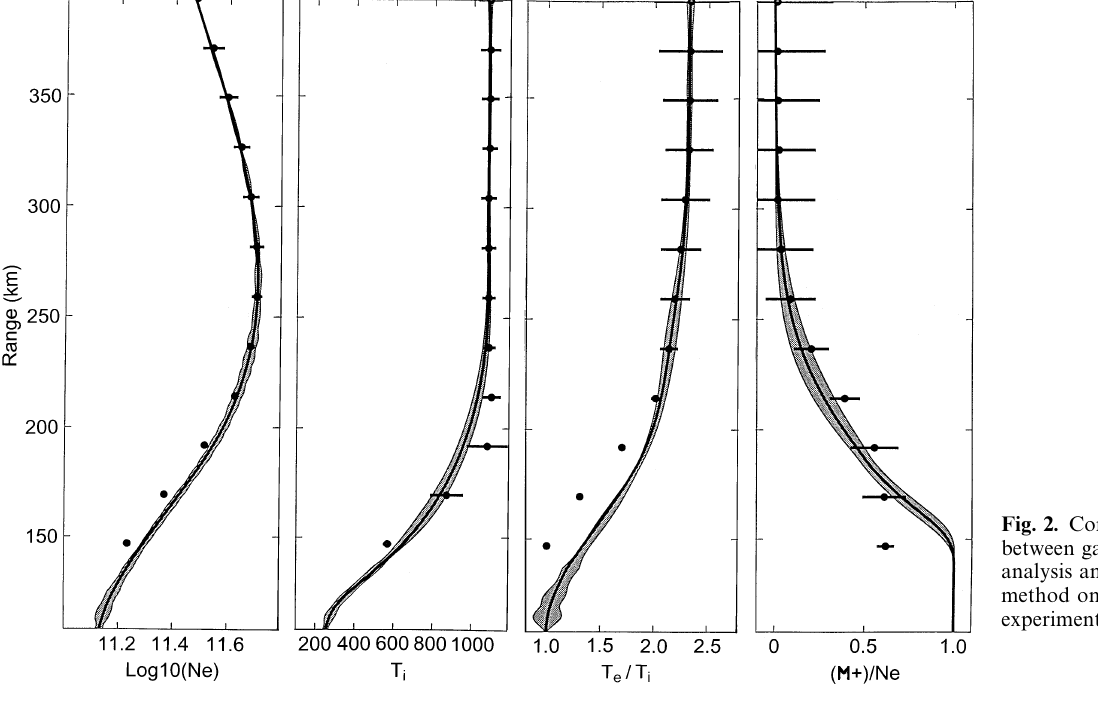
Fig. 2. Comparison between gate-by-gate analysis and global fitting method on simulated CP1